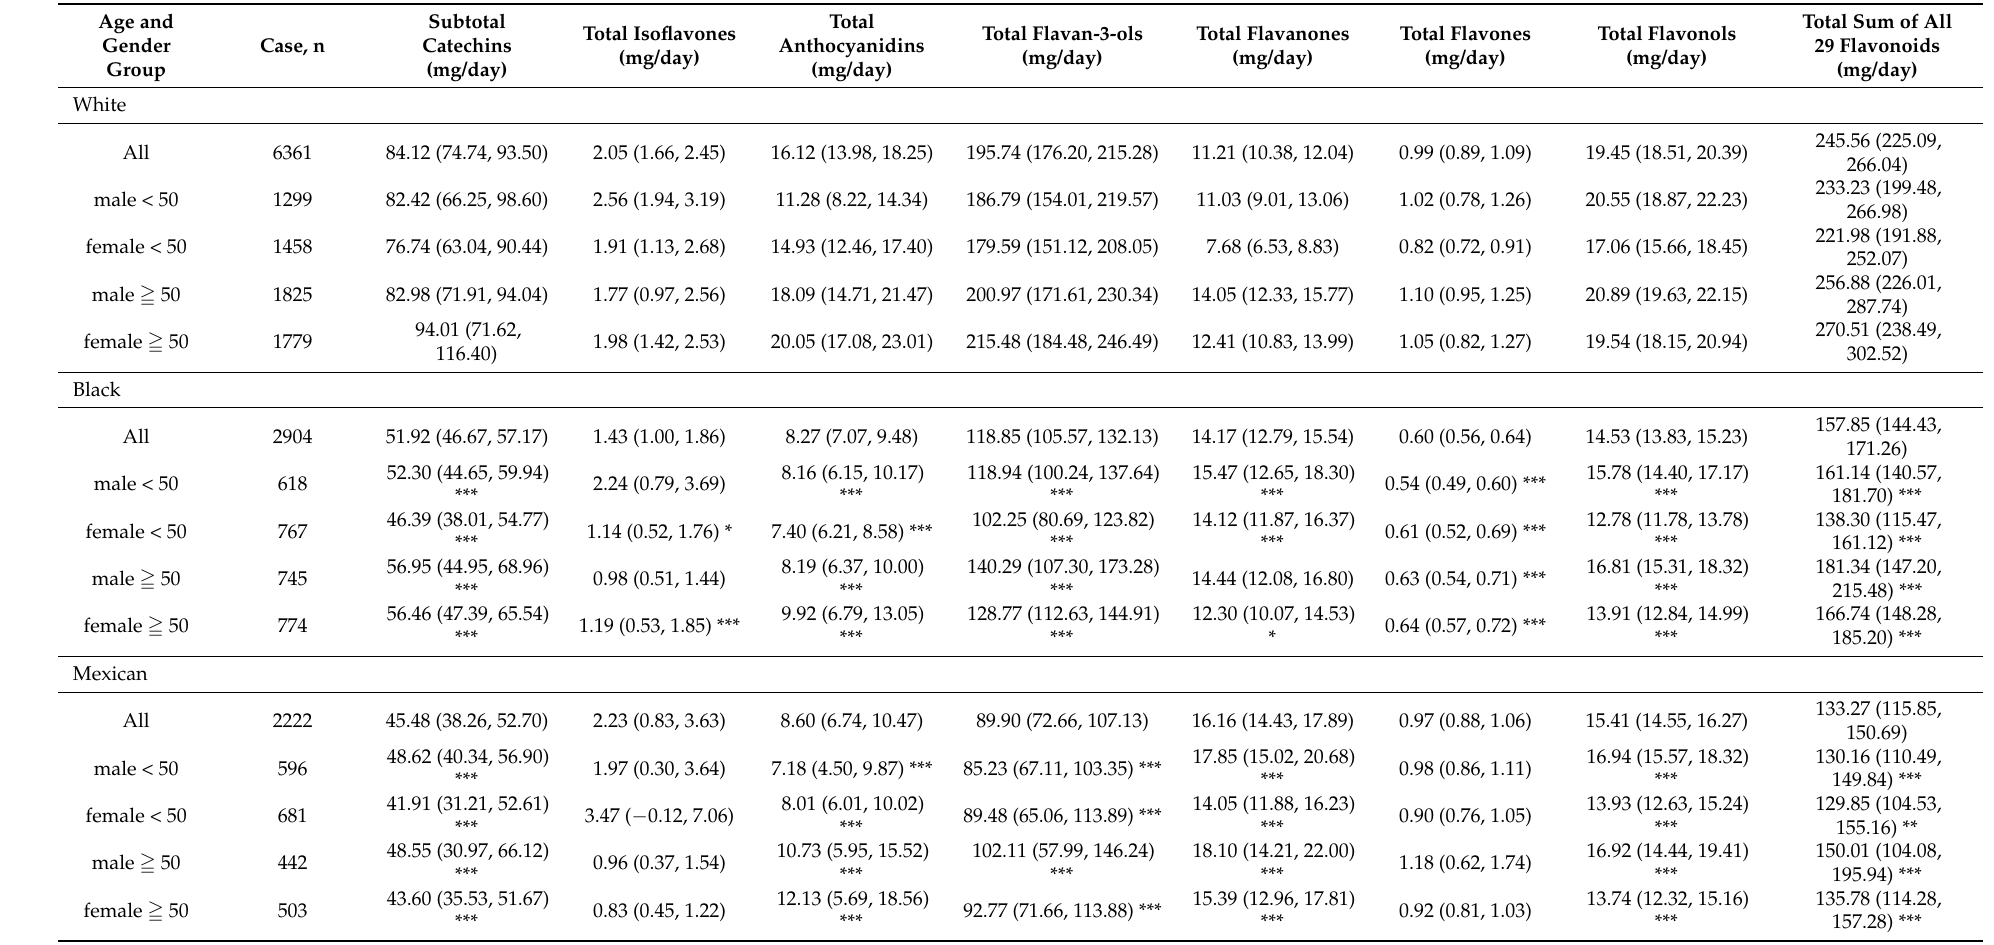
Table 4. Mean dietary intake of flavonoid subclass by age, gender, and ethnic